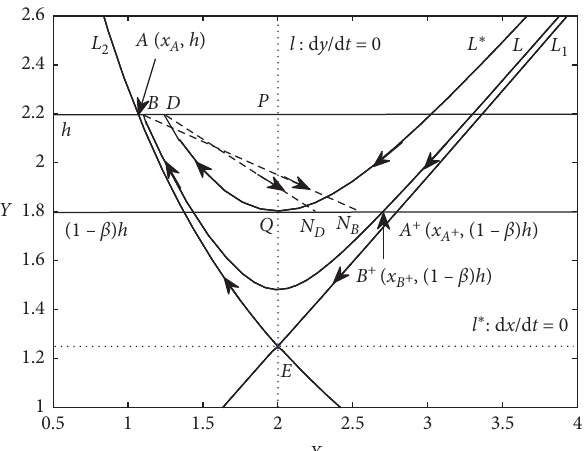
0.5 Figure 6: Trajectory L ∗ passing Q and impulse mapping D of case II with parameter values: a � 5 ,c � 4 ,d � 6 ,e � 3 , h � 2 . 2, and β � 0 .